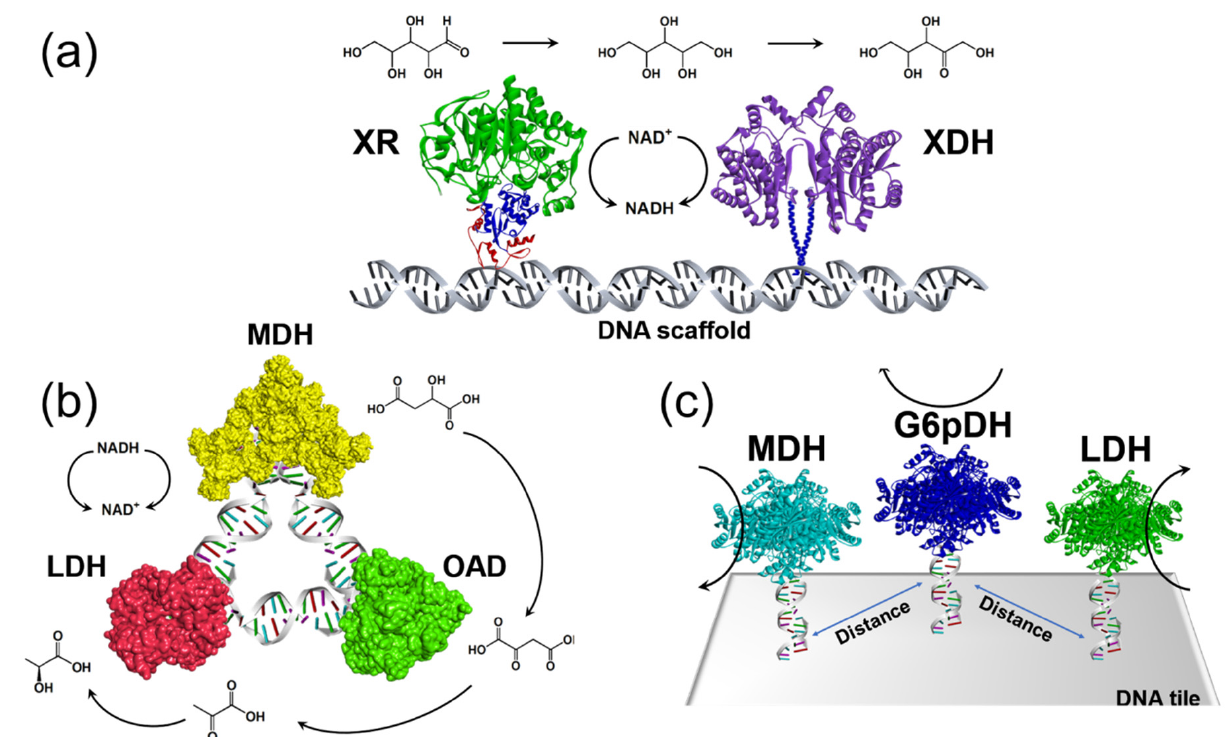
Figure 1. Examples of enzyme cascades co-localized on nucleic acid-based scaffolds. ( a ) Tethering of xylose reductase (XR) and xylitol dehydrogenase (XDH) on a DNA scaffold for the production of xylulose from xylose [37]. ( b ) Co-localization of a co-factor self-sufficient three enzyme system via Watson–Crick pairing of DNA tethers. Malate dehydrogenase (MDH) catalyzes malic acid oxidation to oxaloacetate which is converted to pyruvate by oxaloacetate decarboxylase (OAD). Lactate dehydrogenase (LDH) reduces pyruvate and completes the reduction–oxidation cycle of NAD + and NADH of MDH and LDH [38]. ( c ) Co-assembly of MDH, glucose-6-phosphate dehydrogenase (G6pDH), and lactate LDH on DNA tiles with nanometric control over their spatial arrangement [74].